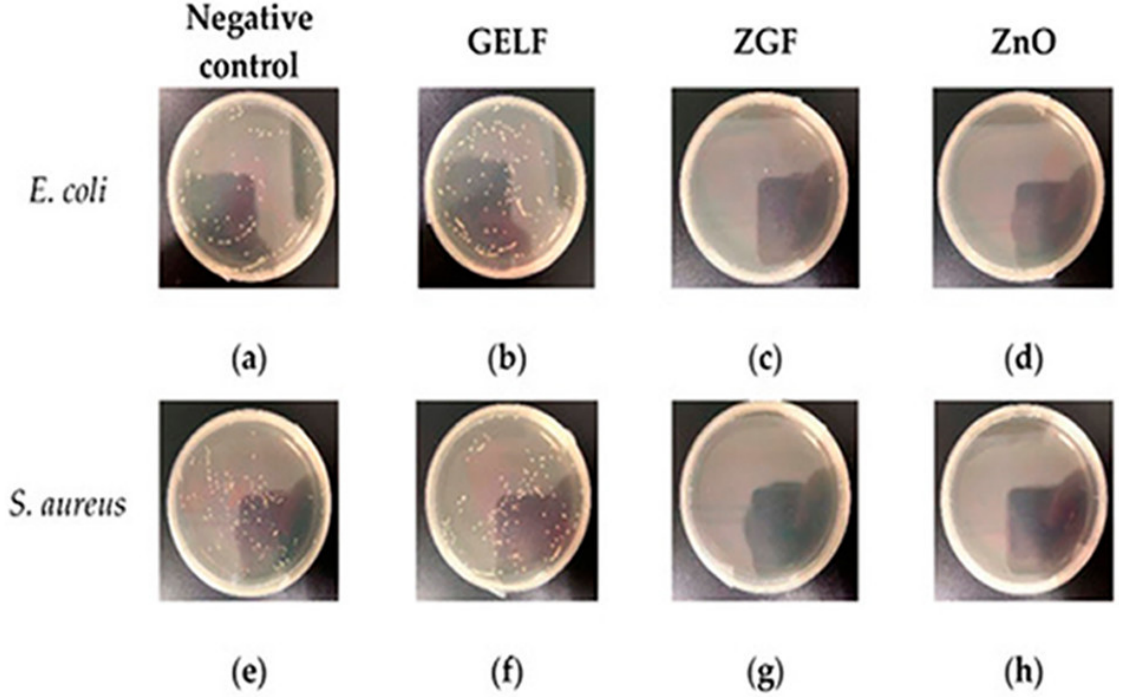
Figure 15. Effect of gelatin/zinc oxide/graphene oxide composite (ZnO) on E. coli and S. aureus com- pared to GELP and ZGF [266]. Reproduced under the Creative Commons Attribution License with permission from ref [258]. Copyright 2017 Elsevier.